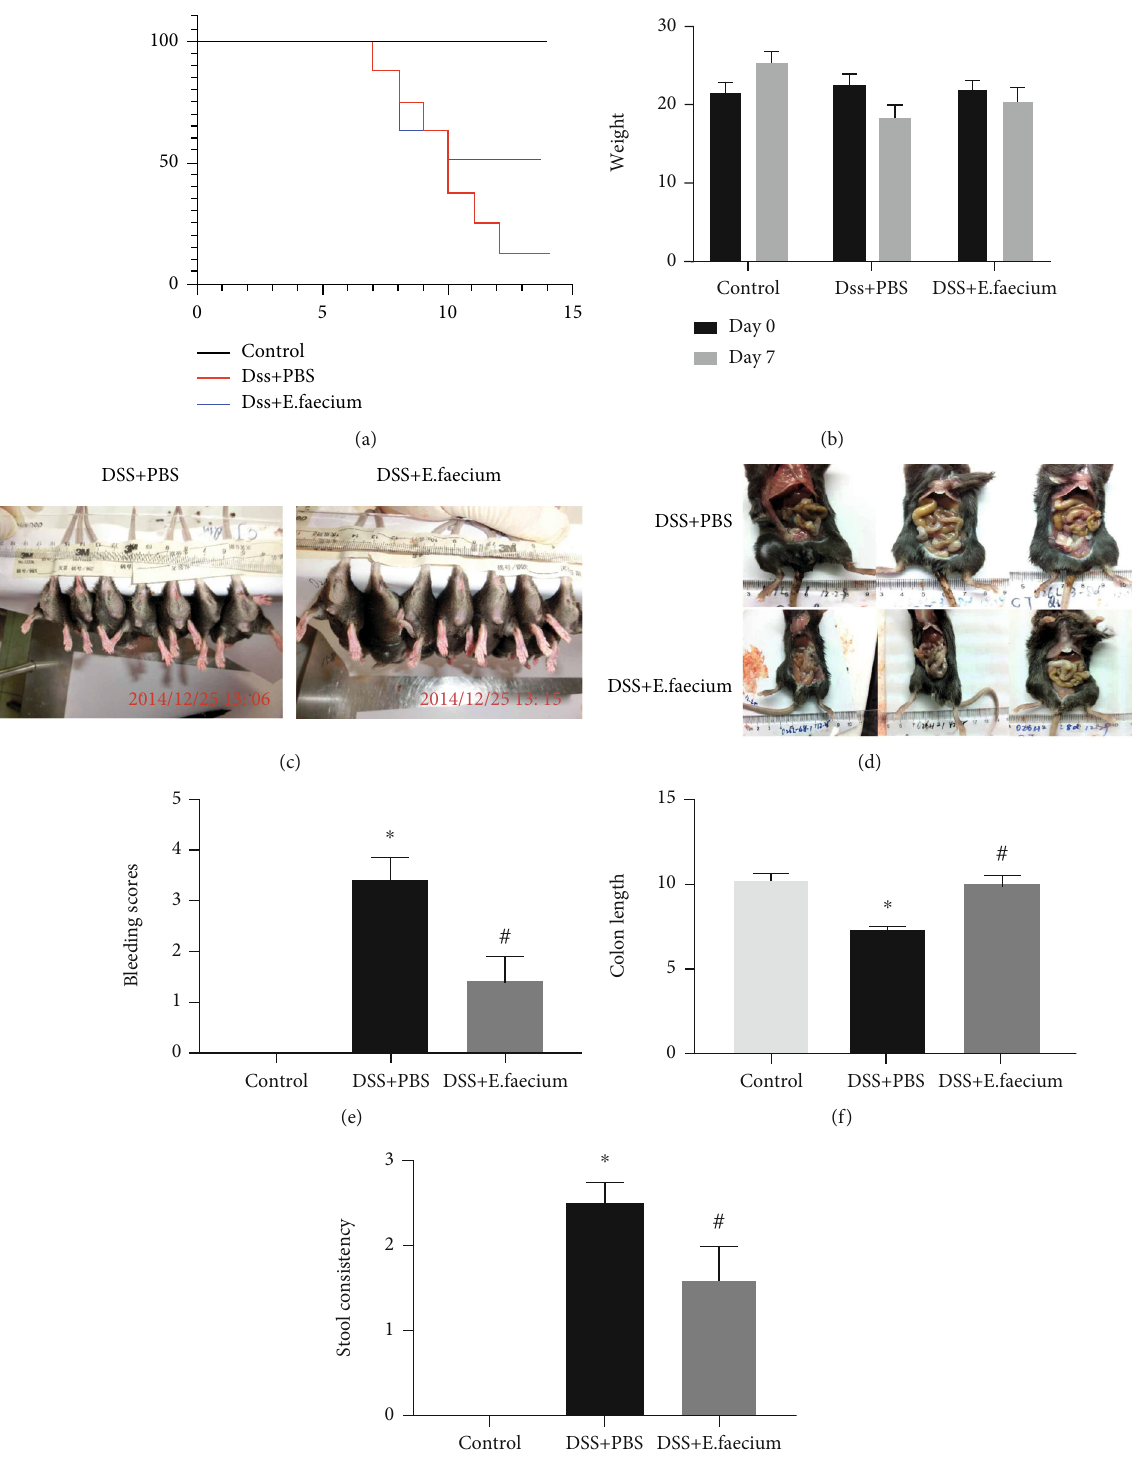
Figure 1: The protective e ff ect of E. faecium against DSS-induced colitis. (a) The survival curve for DSS-induced colitis. (b) Weight loss. (c) Typical image of gut damage. (d) Typical image of colon length. (e) Bleeding scores. (f) Colon length. (g) Stool consistency. ∗ P < 0 : 05 vs. control group; # P < 0 : 05 vs. DSS +PBS